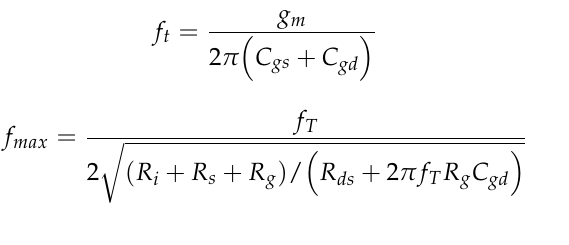
Figure 6. ( a ) Parasitic capacitances ’ varying curves of the basic, GFP, and 2FFP structures and the cut-off frequency and maximum oscillation frequency of ( b ) GFP HEMT and ( c ) 2FFP HEMT.